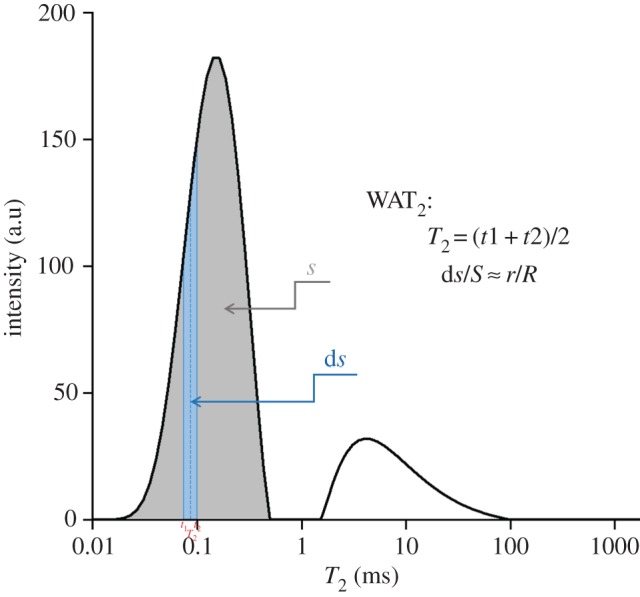
WAT2 schematic diagram.